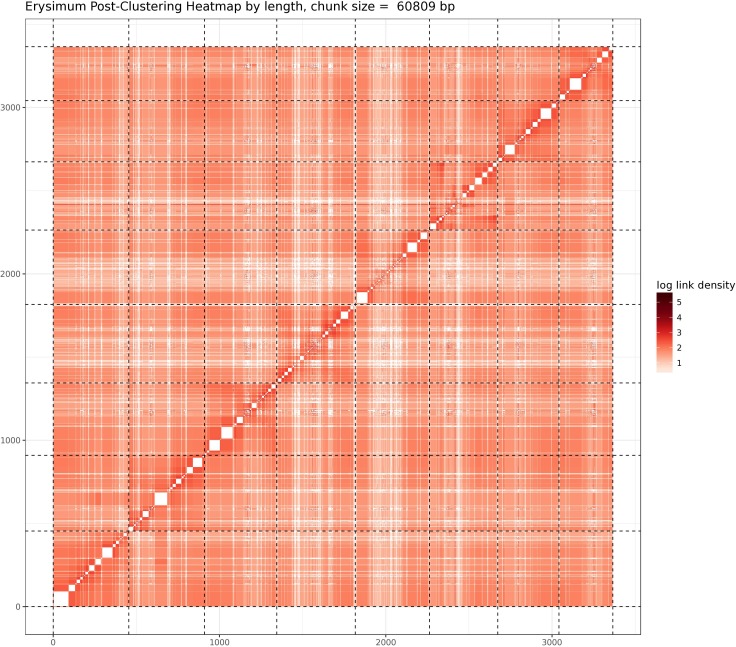
Post-clustering heatmap showing the density of Hi-C interactions between scaffolds used in the assembly.Intensity corresponds to the total number of reads per interaction. Dashed lines delimit the eight identified pseudomolecules.